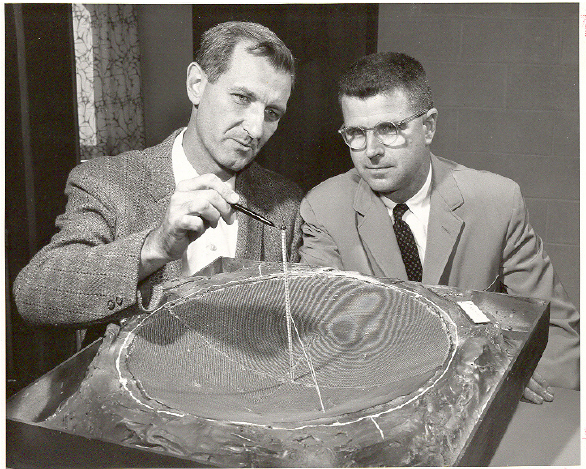
Figure 1. William E. Gordon and William McGuire working with a late 1958 model of the Arecibo radar dish and feed system. Note that the original feed system envisioned was simply a 500- foot tower at the center of the parabolic dish. Professor McGuire was on the faculty of the Cornell Department of Civil Engineer- ing and was involved in the structural design and in the main- tenance of the Arecibo dish and platform structural infrastruc- ture for many decades. (Photo courtesy of Cornell University and Prof. D. B. Campbell; also Robinson et al.,